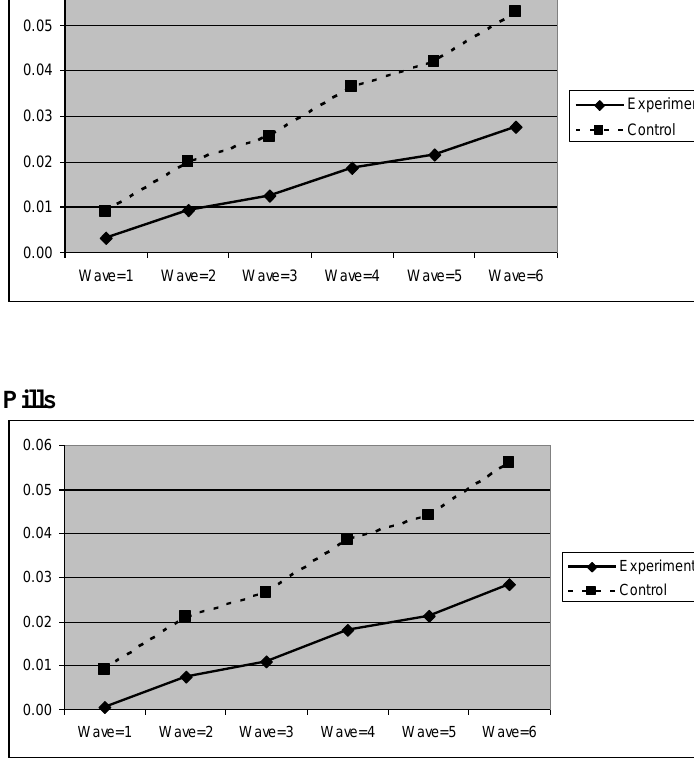
FIGURE 2 . Growth trajectories of the experimental group (participants who joined the Tier 1 Program only) and control group using the item score of cannabis use as the outcome indicator.